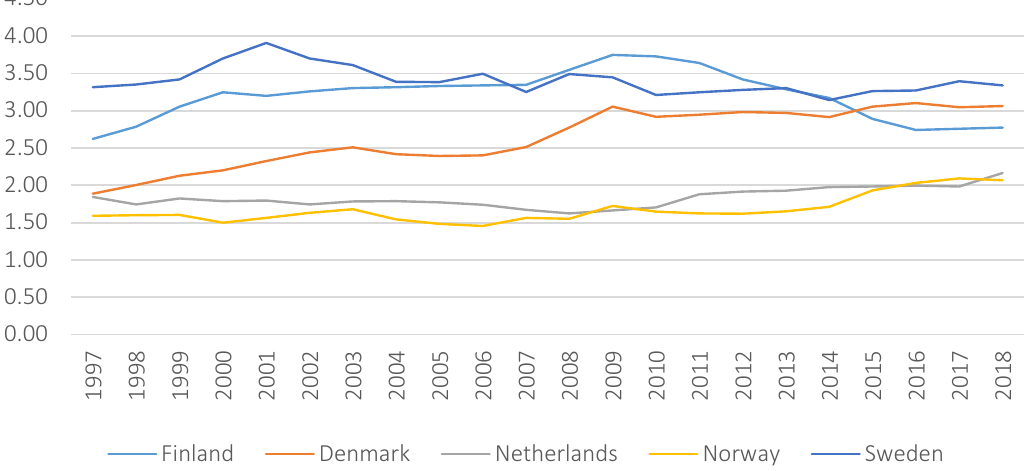
Figure 2. GERD as a share of GDP for selected countries,